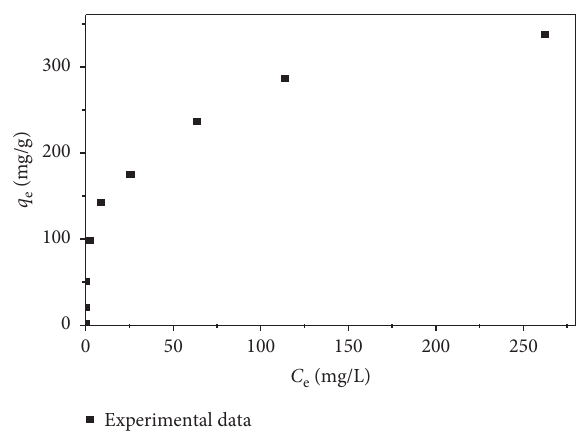
Figure 5: Adsorption isotherm of MO onto activated carbon ( t contact � 2h; adsorbent dose � 1g/L; pH ∼ 7; T � 20 ° C).